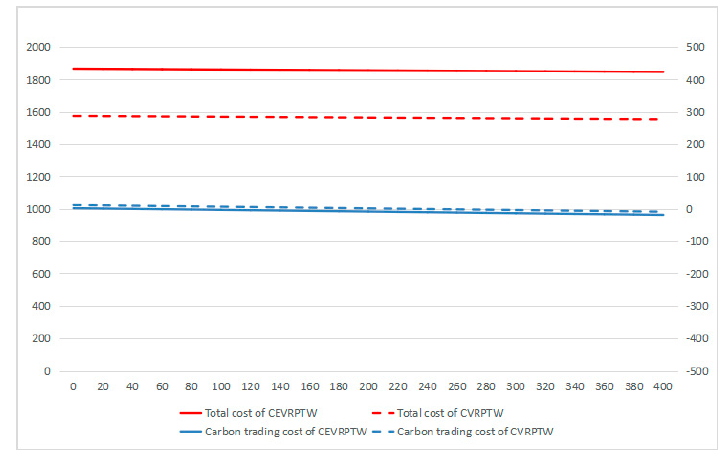
Figure 8. The change of carbon trading cost, total cost under different carbon quota when carbon price